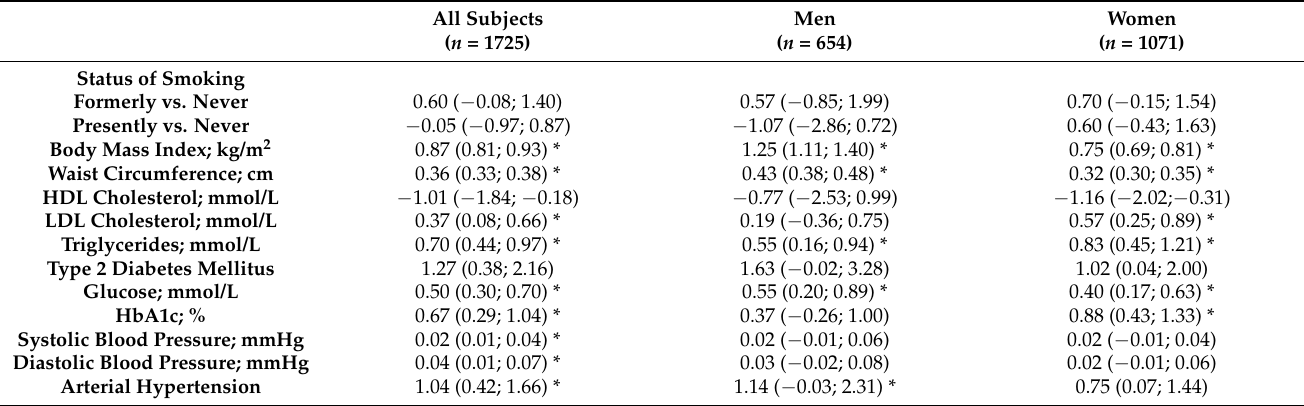
Table 2. Overview on habitus, metabolic variables, smoking status and its associations to parotid gland volume in the final